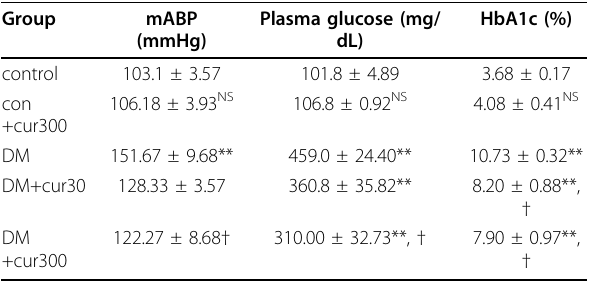
Table 1 Mean arterial blood pressure (mABP;